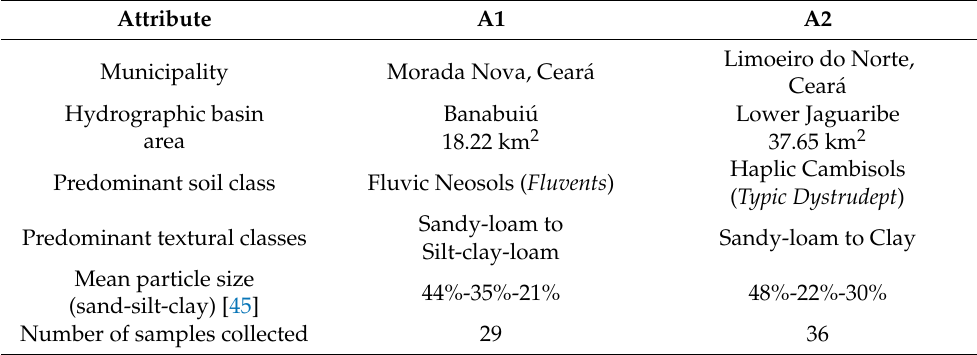
Table 1. Description of the sampling areas and analysed soils, as per the Brazilian System of Soil Classification (SiBCS), with the soil taxonomy in brackets. Attribute A1 A2 Limoeiro do Norte, Municipality Morada Nova, Cear á Cear á Hydrographic basin Banabui ú Lower Jaguaribe area 18.22 km 2 37.65 km 2 Haplic Cambisols Predominant soil class Fluvic Neosols ( Fluvents ) ( Typic Dystrudept ) Sandy-loam to Predominant textural classes Mean particle size Number of samples